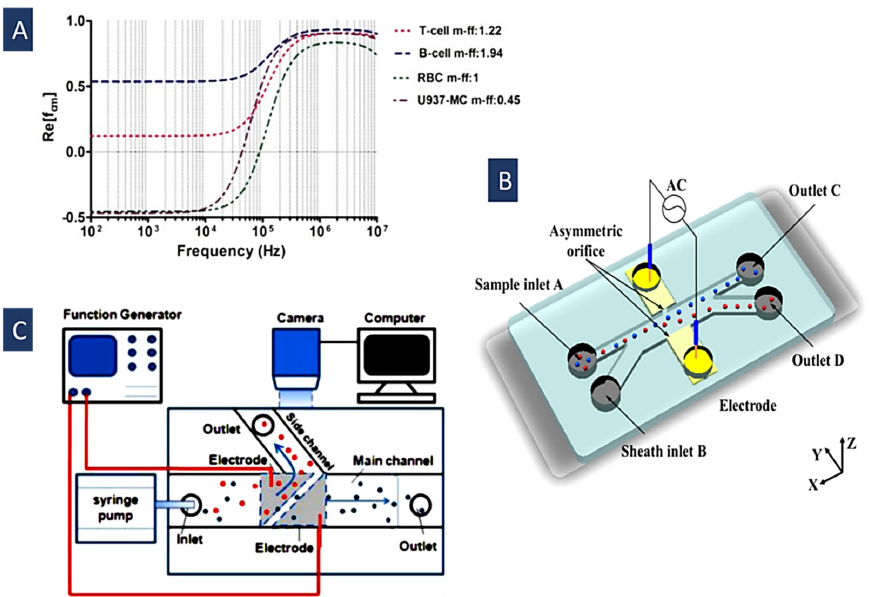
Figure 4. ( A ) Re( f CM ) at different frequencies for blood cells(Reprinted with permission from